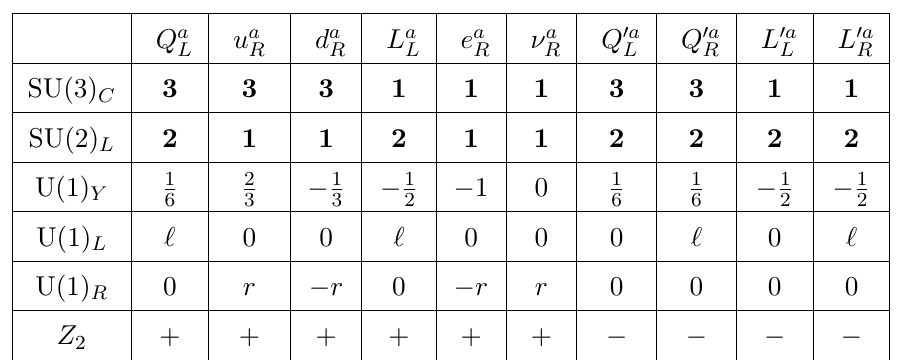
Table 1 . Charge assignments of the our (cid:12)elds under SU(3) C (cid:2) SU(2) L (cid:2) U(1) Y (cid:2) U(1) L (cid:2) U(1) R with r; ‘ 6 = 0, where their upper indices a are the number of family that run over 1 (cid:0) 3. gauge extension give two extra neutral gauge bosons in which right-handed partner of the SM fermions are introduced [16{18]; similar structure is also found in a model in ref. [19] . In these models the SM fermions are not charged under SU(2)